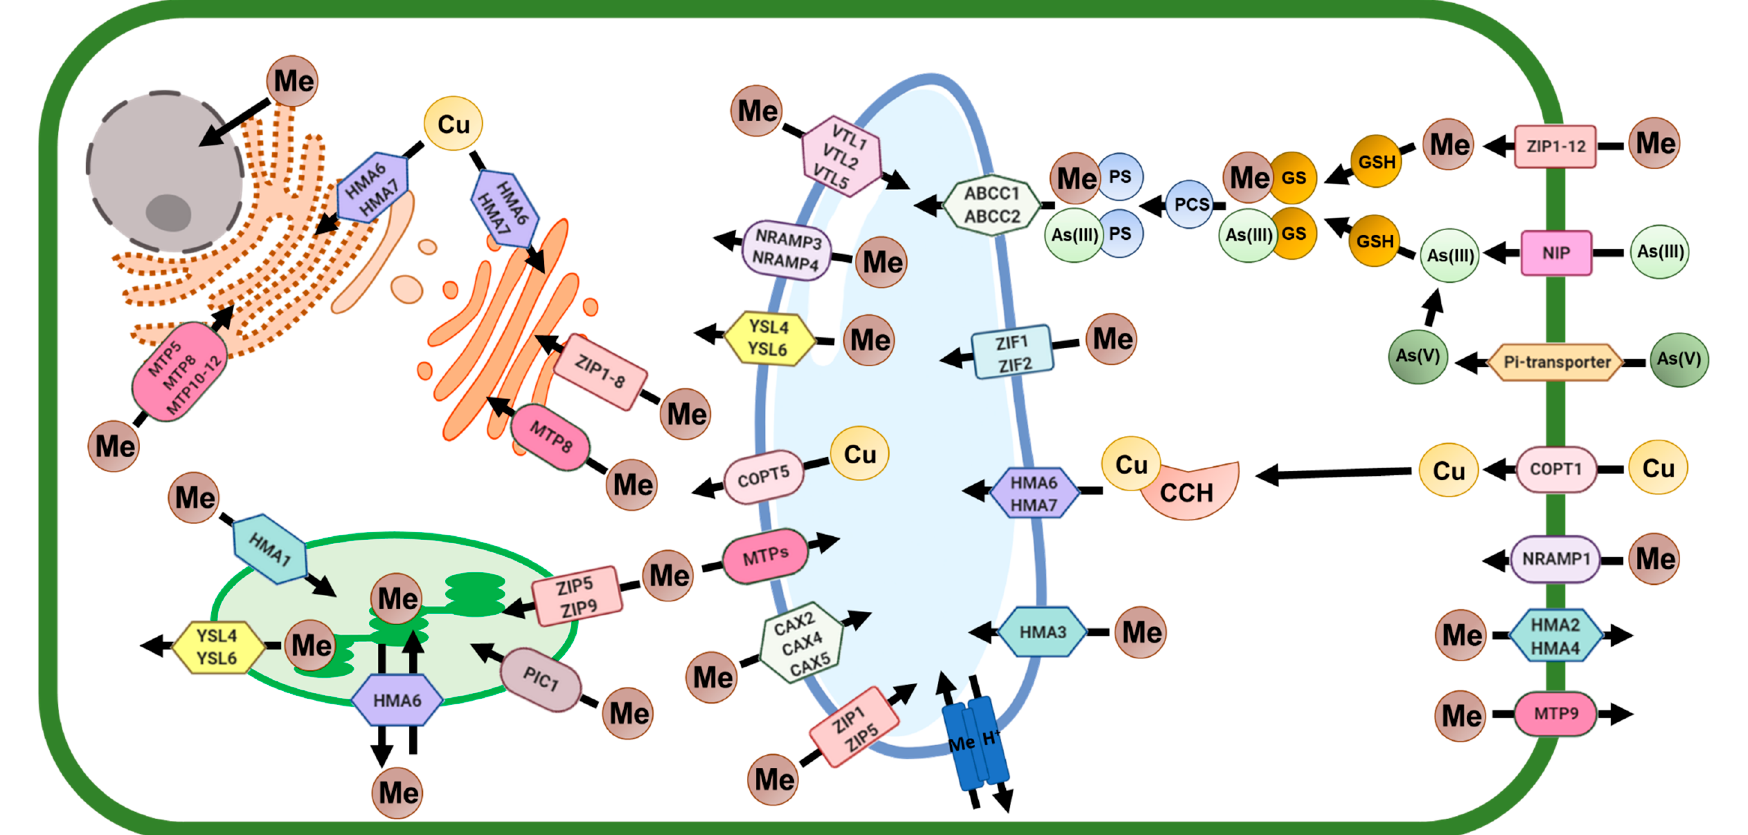
Figure 2. Summary of subcellular heavy metal transport in plant cells. Metal transporter proteins participating in heavy metal transport into and out of cellular organelles are presented. ABCC—ATP-binding cassette subfamily C protein; As—arsenic; CAX—Ca 2+ exchanger; COPT—copper transporter; CCH—copper chaperone; Cu—copper; GS—glutathione conjugates; GSH—glutathione; HMA—heavy metal ATPase; Me—heavy metal; MTP—metal tolerance proteins; NIP—nodulin 26-like intrinsic protein; NRAMP—natural resistance-associated macrophage protein; PS—phytochelatin conjugates; PCS—phytochelatin synthase; Pi-transporter—phosphorus transporter; VTL—vacuolar-iron transporter-like; ZIF—zinc induced facilitator; ZIP—zinc regulated transporters; YSL—yellow stripe like (metal-nicotianamine transporter) (based on [97–99]).